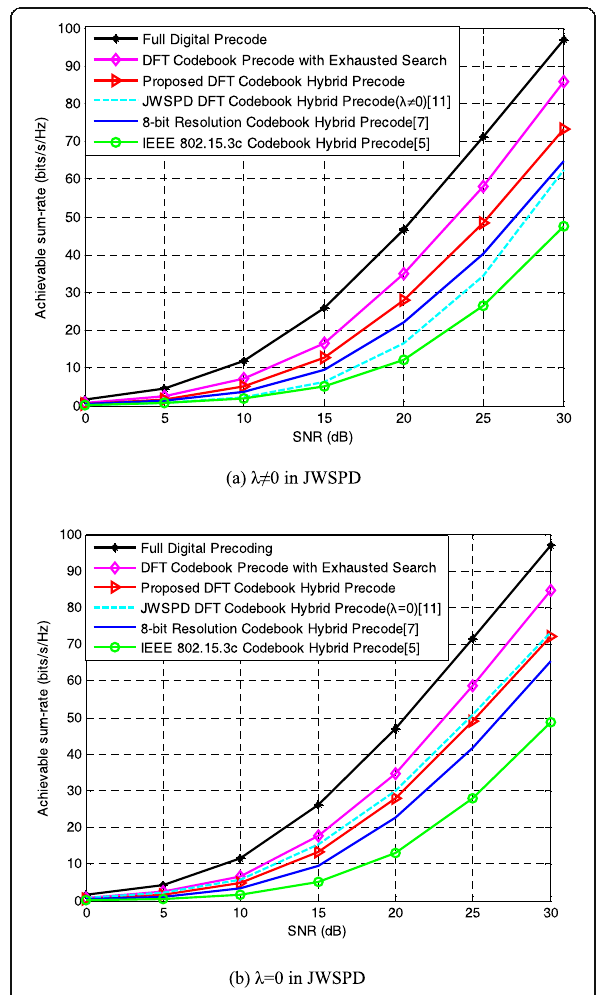
Fig. 3 The achievable sum rate vs. SNR ( N BS = 128 and U = 16 with 1-antenna ’ s MS). a λ ≠ 0 in JWSPD. b λ = 0 in